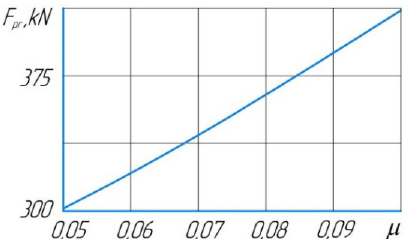
Figure 6. Required press force vs. friction coefficient at μ at α = 27°, β = 33°